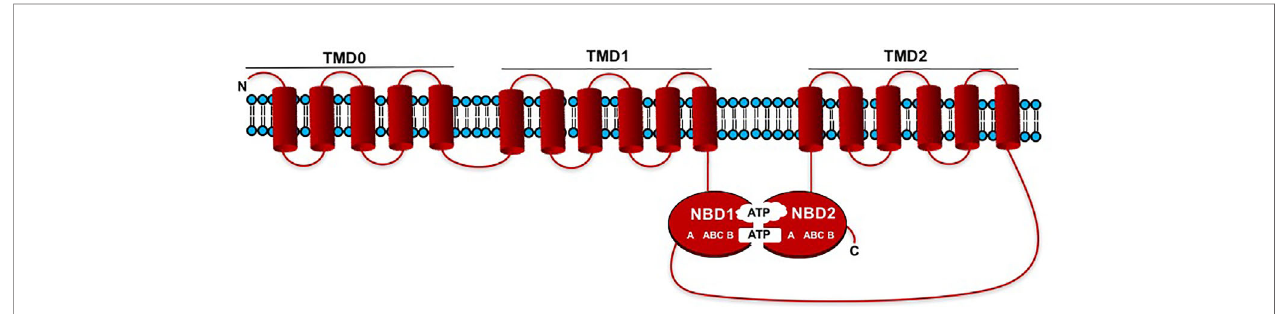
FIGURE 2 | Schematic representation showing the membrane topology models of MRP-type ABCC transporters. The domains are forward oriented in the following way: TMD0_TMD1-NBD1_TMD2-NDB2. NBDs contain the Walker A and Walker B motifs separated by an ABC “ signature ”